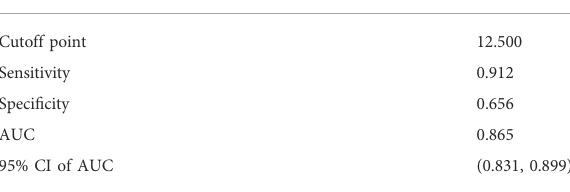
TABLE 5 The characteristics of ROC